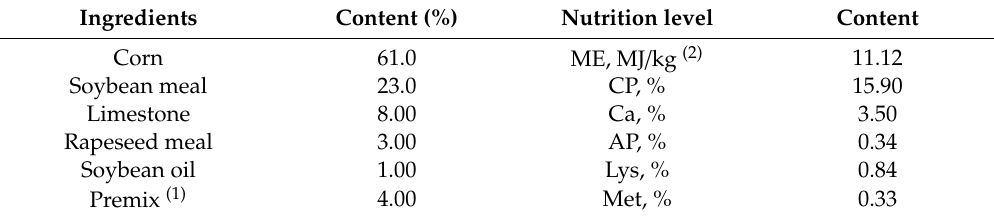
Table 1. Composition and nutrients of the basal diet (air-dry